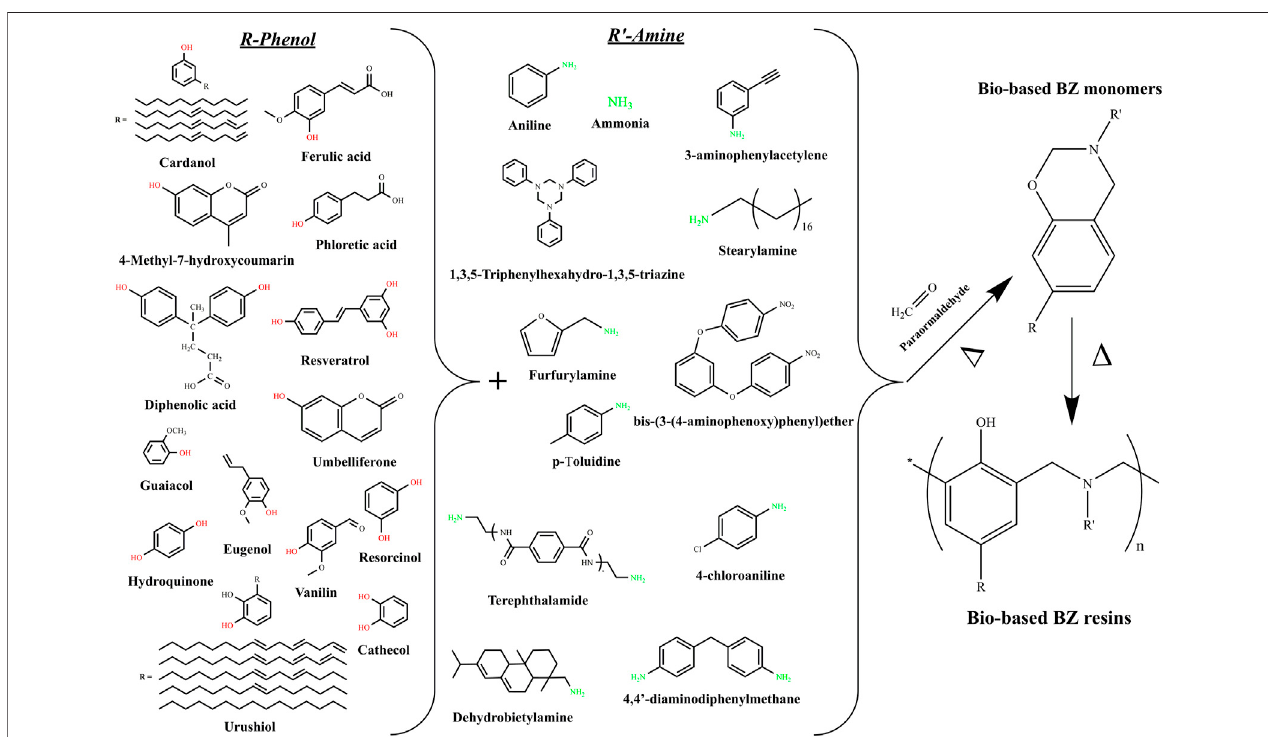
FIGURE 1 | Synthetic routes of bio-based benzoxazine